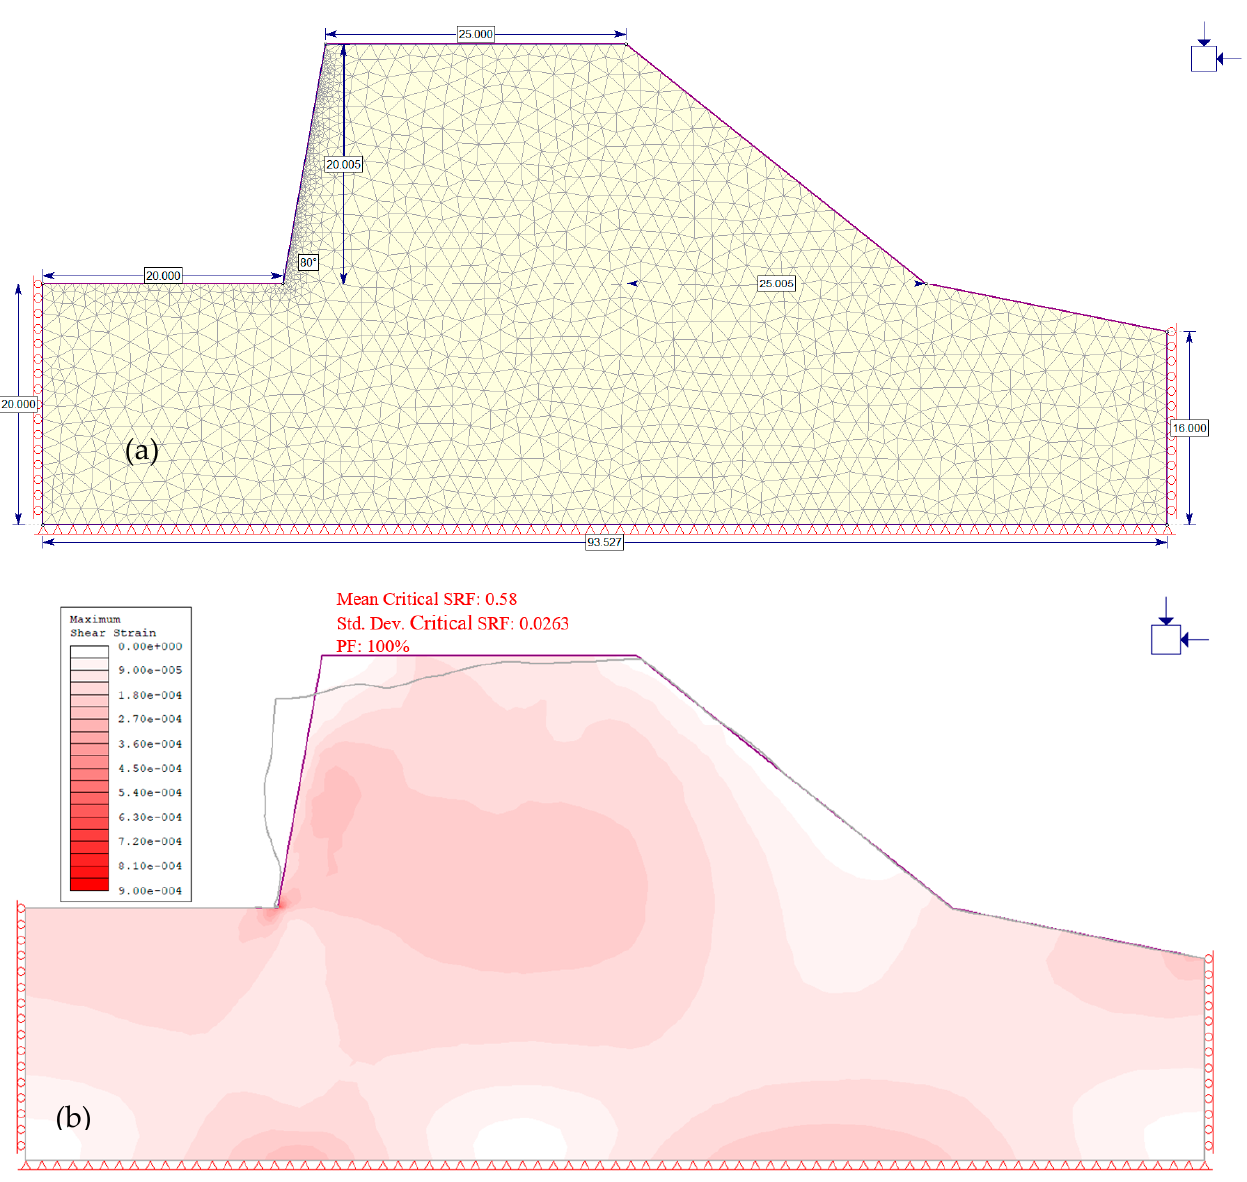
Figure 7. ( a ) Dimension and mesh of slope at 80° angle; ( b ) probable resultant deformation of steep quarry slope.